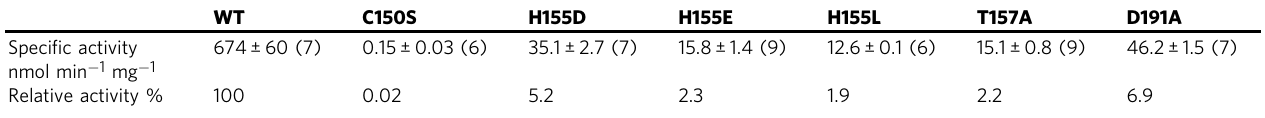
Data are means and standard errors; the numbers of independent experiments (see Methods) are provided in parentheses. Experiments were performed with 10 µ M 5-InsP 7 ; a colorimetric assay was used to determine Pi release, except for the C150S mutant, for which 5-[ 3 H]InsP 7 hydrolysis was directly monitored by HPLC (see Methods and Supplementary Fig. 3). Source data are provided as a Source Data fi